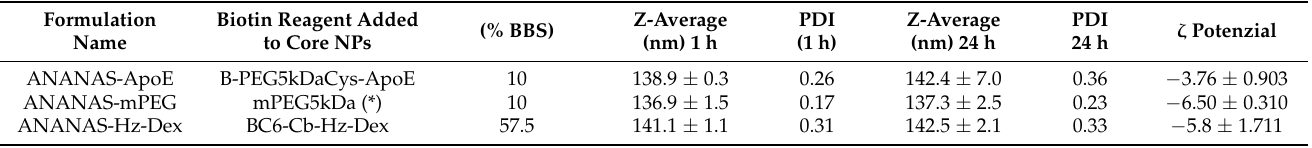
Table 2. Composition and size of the formulations used in the in vivo